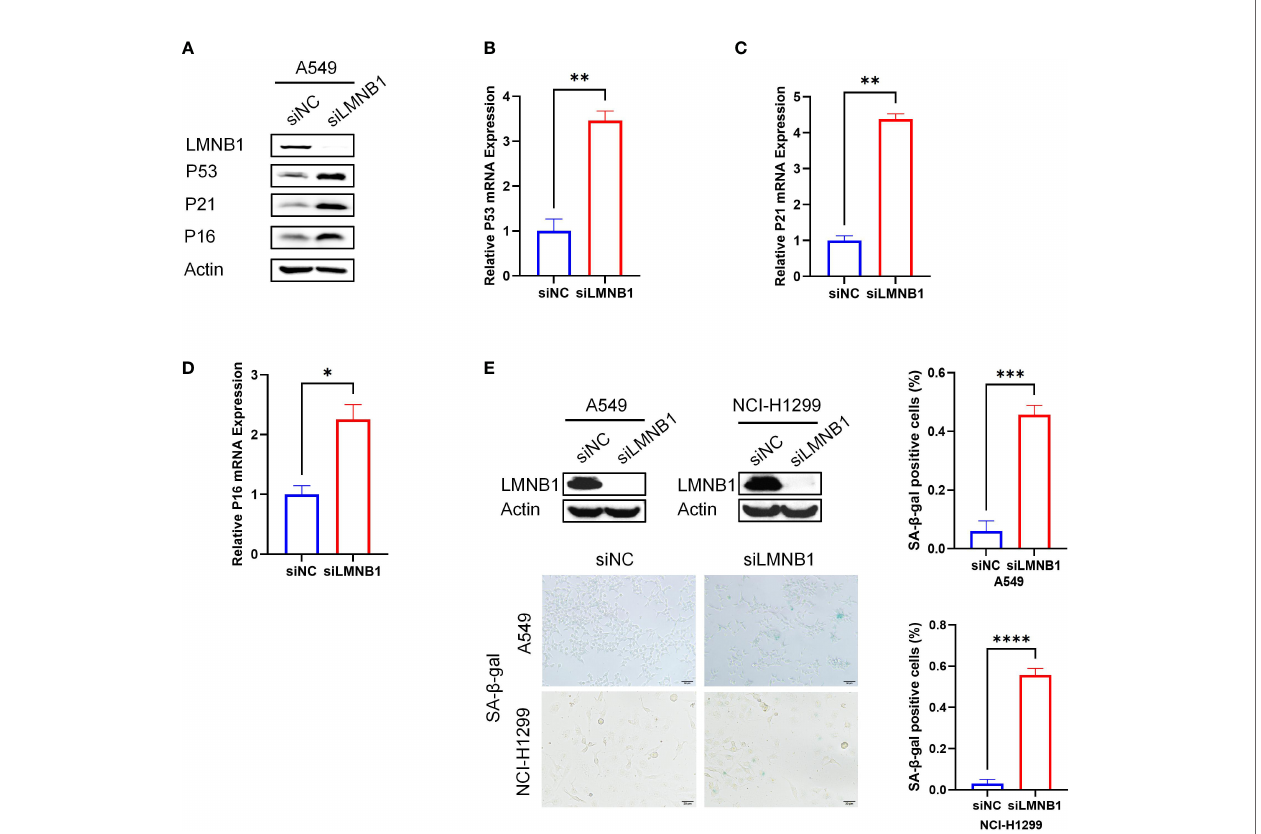
FIGURE 4 | The absence of LMNB1 can induce LUAD cells senescence. (A) WB detected the expression of protein LMNB1, P53, P21, P16 and Actin in A549 siLMNB1 and siNC cells. (B-D) The expression of P53, P21 and P16 mRNA in A549 siLMNB1 cells and the control group were detected by RT-qPCR. (E) Proportion of senescent cells of A549 siLMNB1 cells and A549 siNC cells were detected by SA- b -Gal staining. The percentage of senescence positive cells in each group from fi ve randomly chosen fi elds was calculated. *p<0.05. **p<0.01, ***p<0.001,